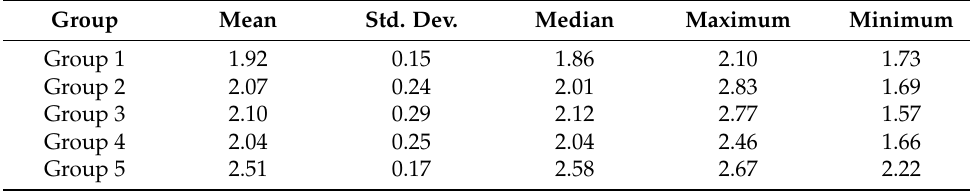
Table 5. Emissions of electrical origin per household, in tCO 2 /year. Group